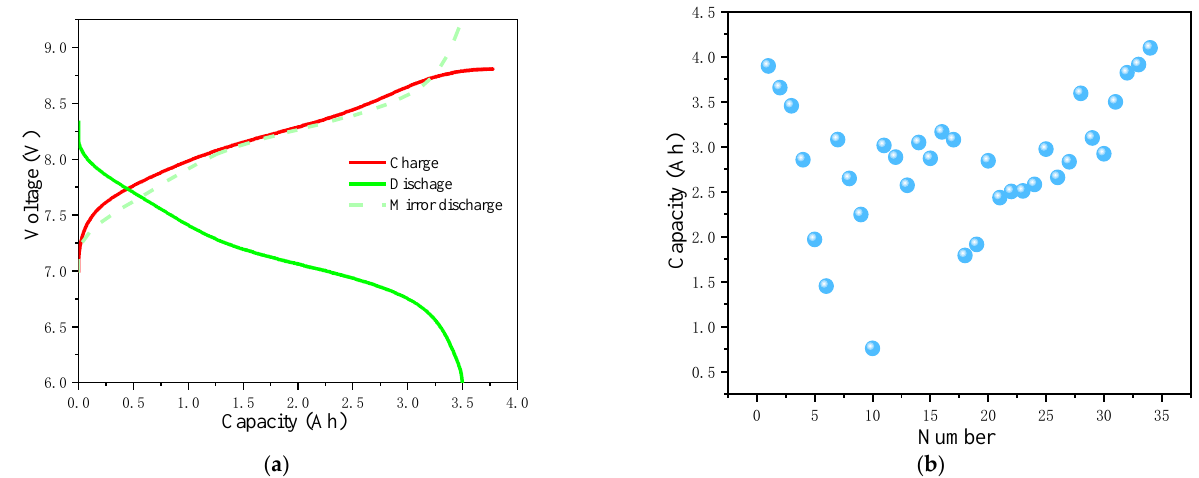
Figure 3. R-N6 battery distribution map. ( a ) Charge and discharge curve; ( b ) discharge capacity distribution map.